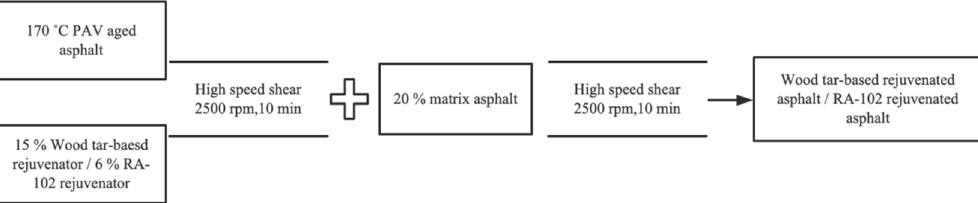
Figure 1. Preparation process of rejuvenated asphalt.